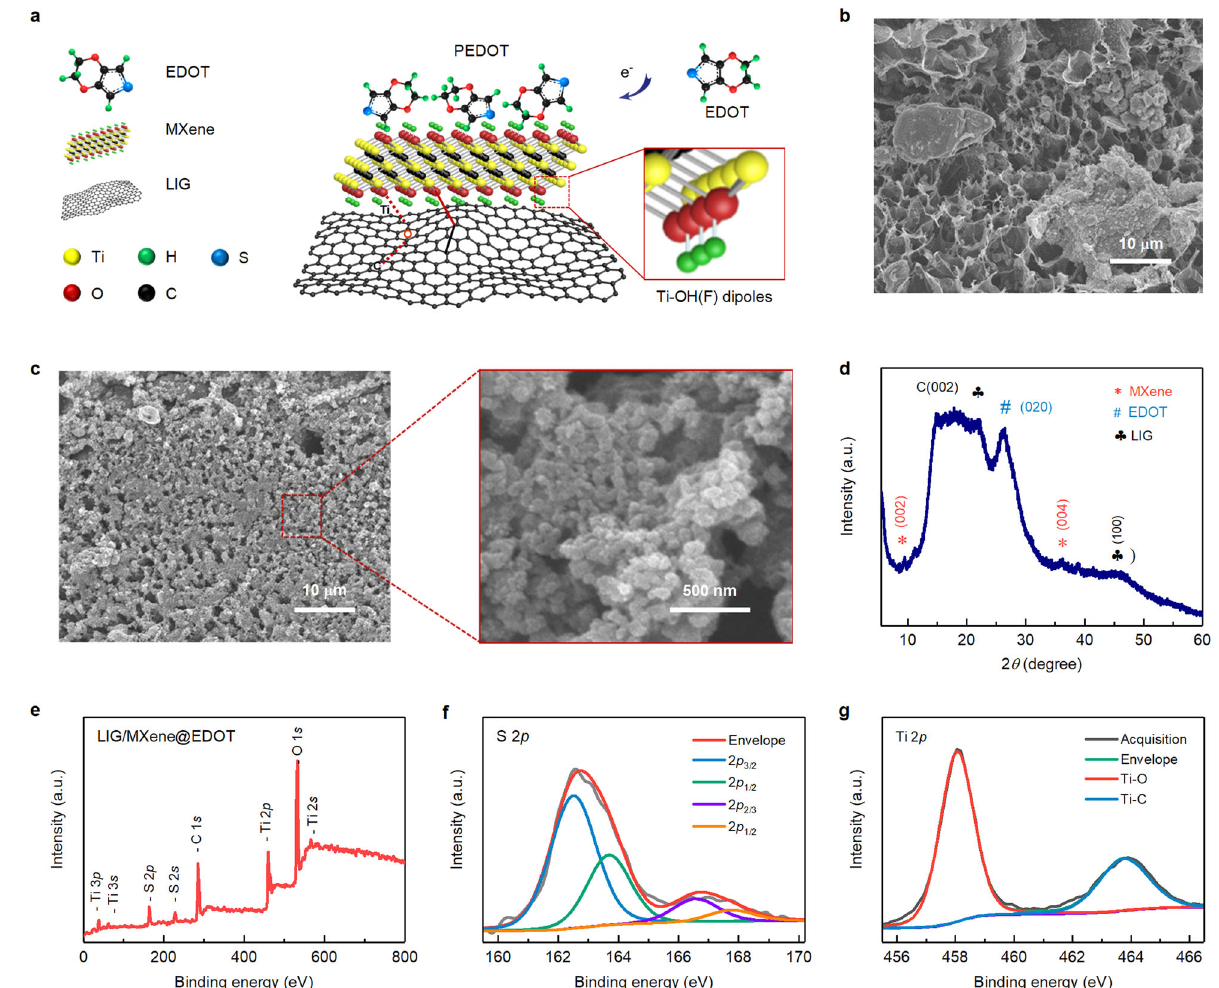
Fig. 2 Physical characterization of the composite material. ( a ) 3D chemical and physical crosslinking of the LIG, MXene-Ti 3 C 2 T x , and EDOT. ( b ) FESEM image of drop-casted MXene-Ti 3 C 2 T x @EDOT on LIG. ( c ) FESEM image of MXene-Ti 3 C 2 T x @EDOT on LIG after electrophoretic deposition (high-resolution FESEM in inset). ( d ) XRD and ( e ) XPS survey spectrums of LIG/MXene-Ti 3 C 2 T x @EDOT composite. XPS spectrum of ( f ) S 2 p and (G) Ti 2 p